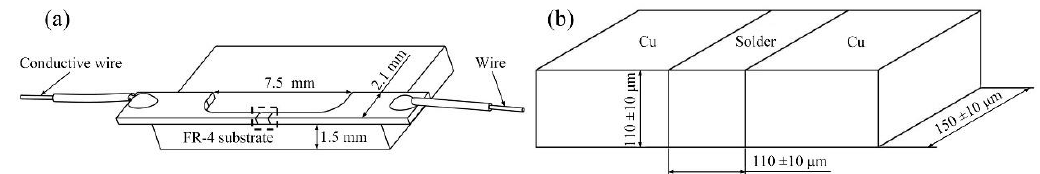
Figure 1. Schematic of the experiment configuration ( a ) and the final dimension of the solder joint ( b ) marked by the dash-line in ( a ).